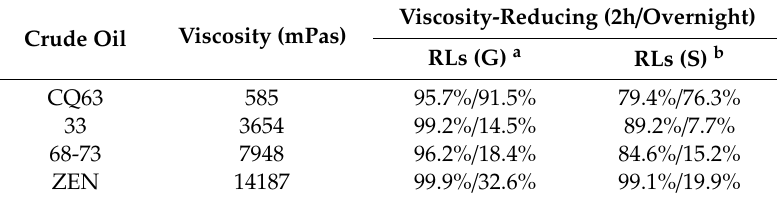
Table 3. Viscosity-reducing e ff ect of rhamnolipid products.